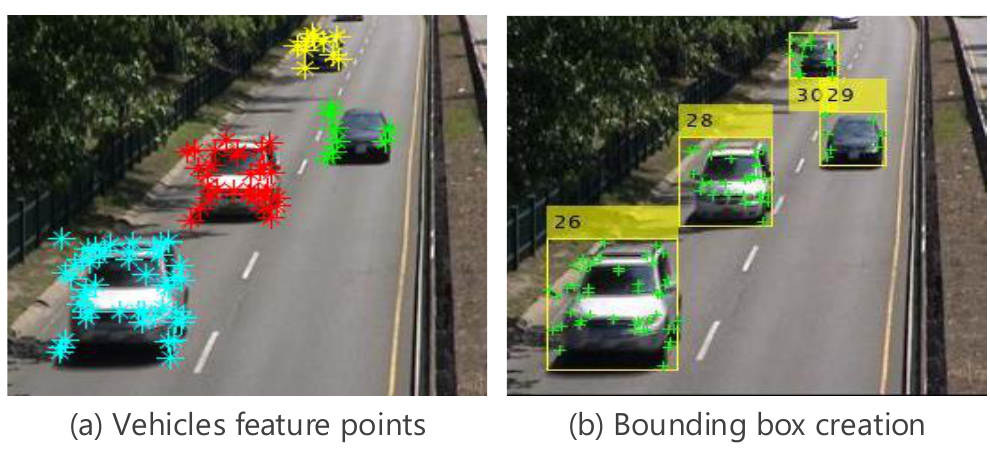
Figure 6. Variable bounding box.